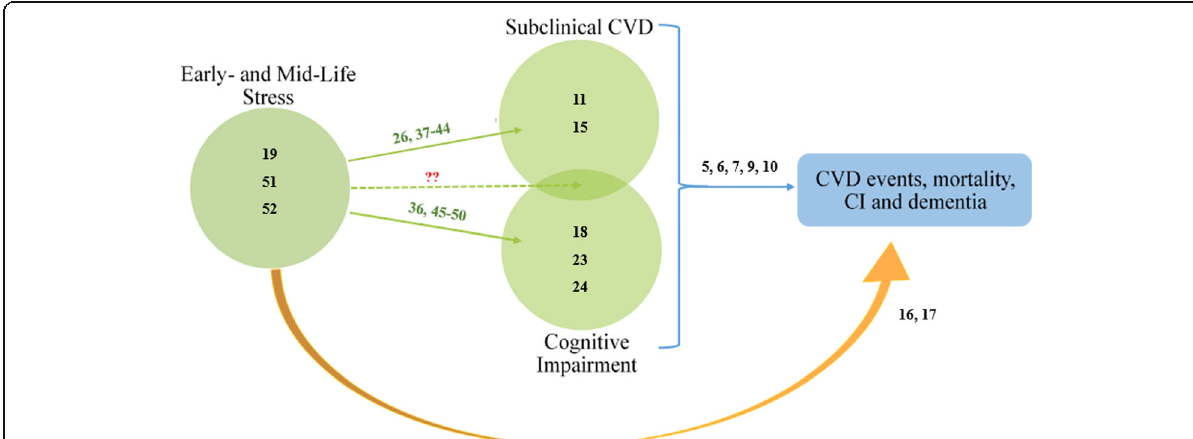
Fig. 1 Relationship between early- and mid-life stress and methylated genes associated with adverse health. Blue arrow represents the latter relationship and studies supporting this are depicted by black numbers. Orange arrow represents the relationship between life stress and future CVD events, mortality, CI and dementia, with black numbers representing studies supporting this relationship. Black numbers within green circles represent studies which have analyzed methylated genes within that category alone. Green arrows represent the relationship between life stress and methylated genes implicated in (top) subclinical CVD; (bottom) CI; and (middle) both subclinical CVD and CI. Studies analyzed in this systematic review which illustrate these relationships are depicted by green numbers. Red question marks illustrate no studies found to support this relationship. Numbered studies can be found in the References